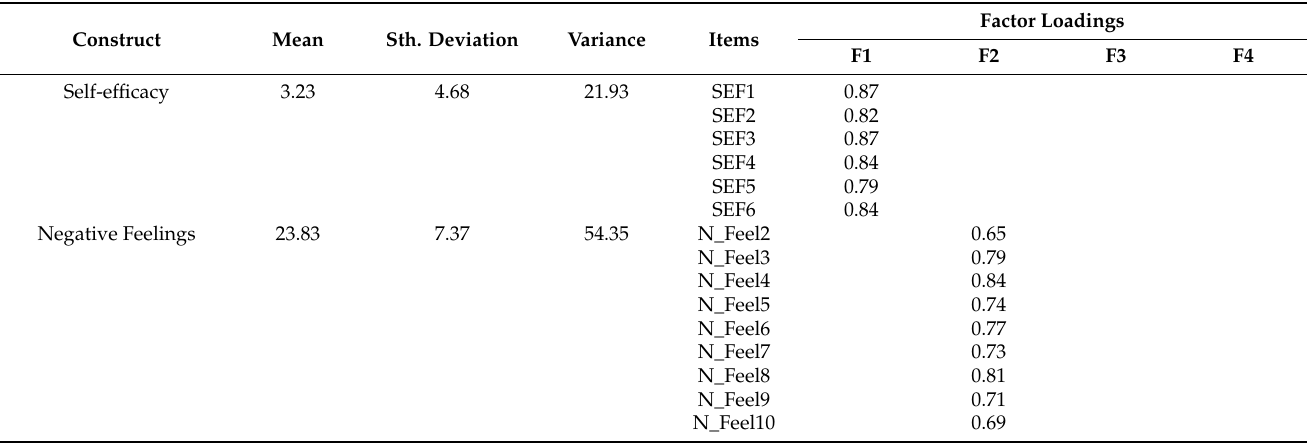
Table 2. Initial factor analyses and dimensionality